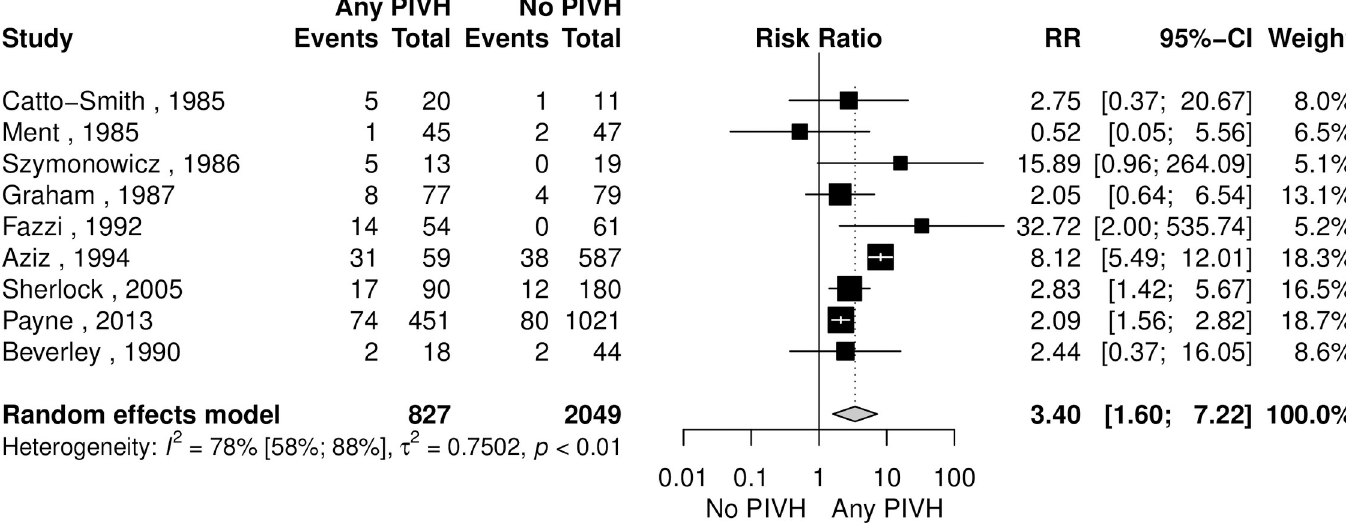
PLOS ONE | https://doi.org/10.1371/journal.pone.0223427 October 10,